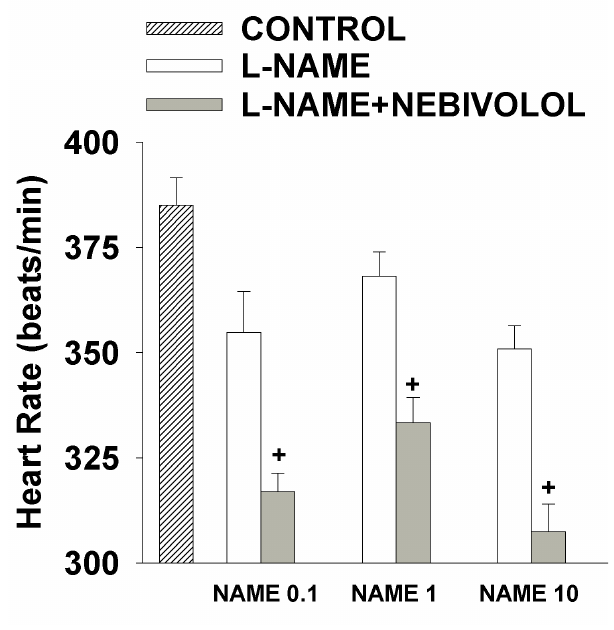
FIGURE 2 . Heart rate in the experimental groups after 2 weeks of treatment. +, p < 0.05 vs. L-NAME–treated group.